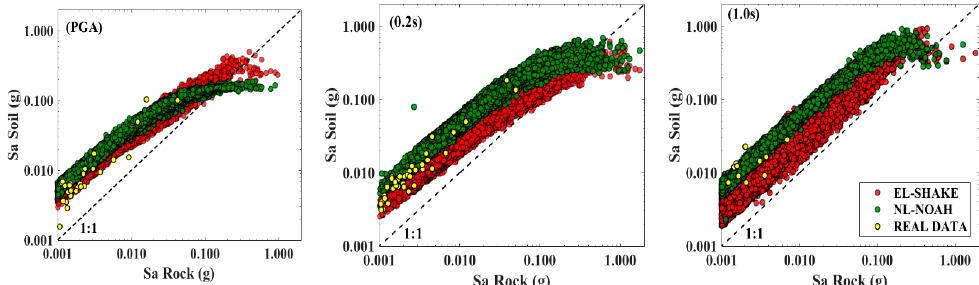
Figure 21. Equivalent-linear (SHAKE91, red) and nonlinear (NOAH, green) predicted accelerations compared with data recorded at Euroseistest (yellow), for three different spectral periods (PGA, 0.2 s and 1.0 s).